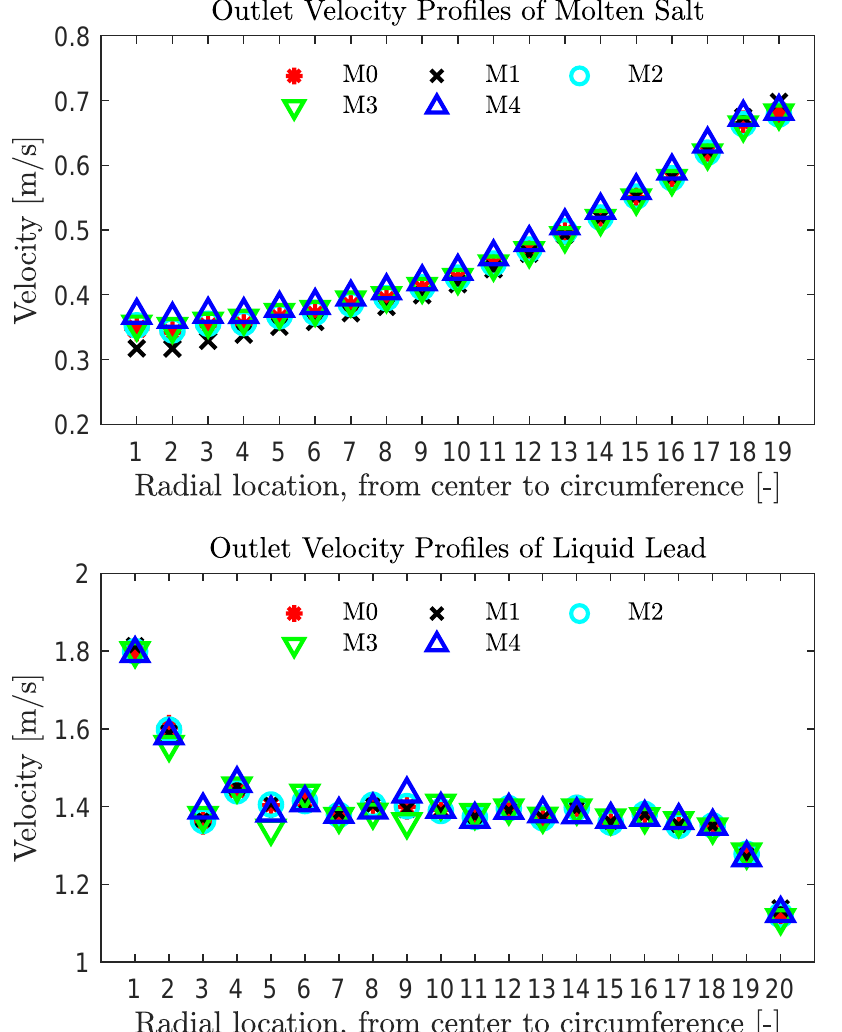
Figure 9. Mesh convergence study of outlet velocity distribution: top, velocity profiles of molten salt; bottom, velocity profiles of liquid